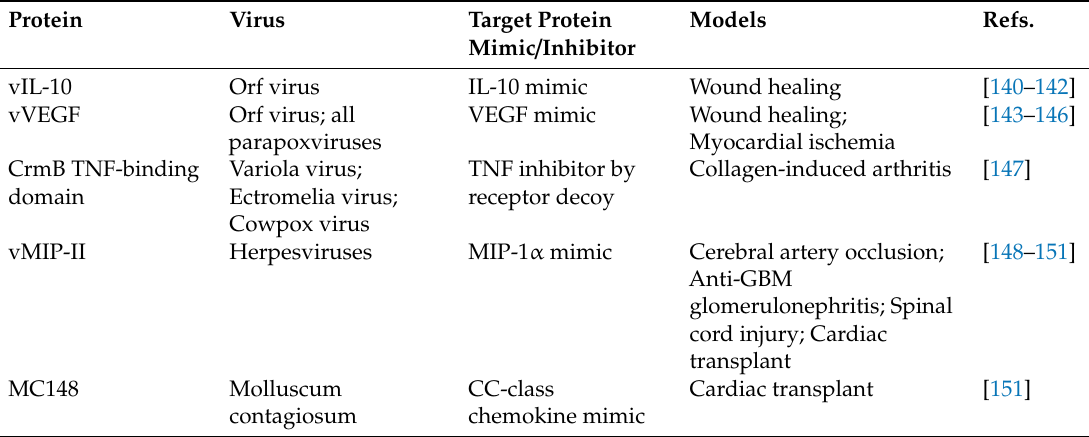
Table 3. Viral cytokine and growth factor mimics and inhibitors with therapeutic e ffi cacy. Protein Virus Target Protein Models Mimic / Inhibitor